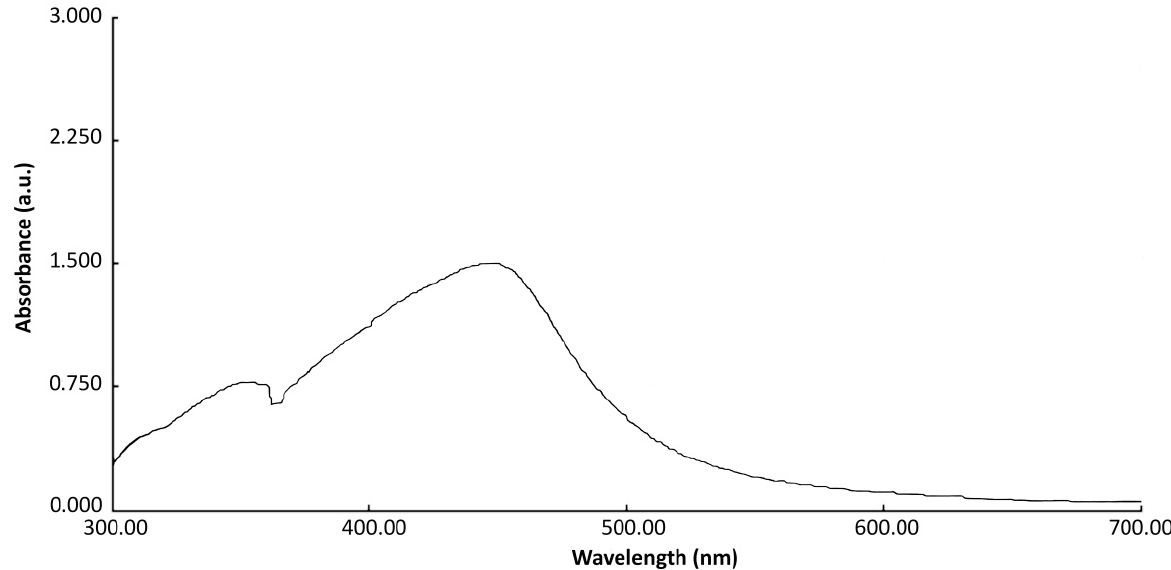
Figure 1. Ultraviolet (UV)/visible light (Vis) spectrum of the synthesized silver nanoparticles (AgNPs).